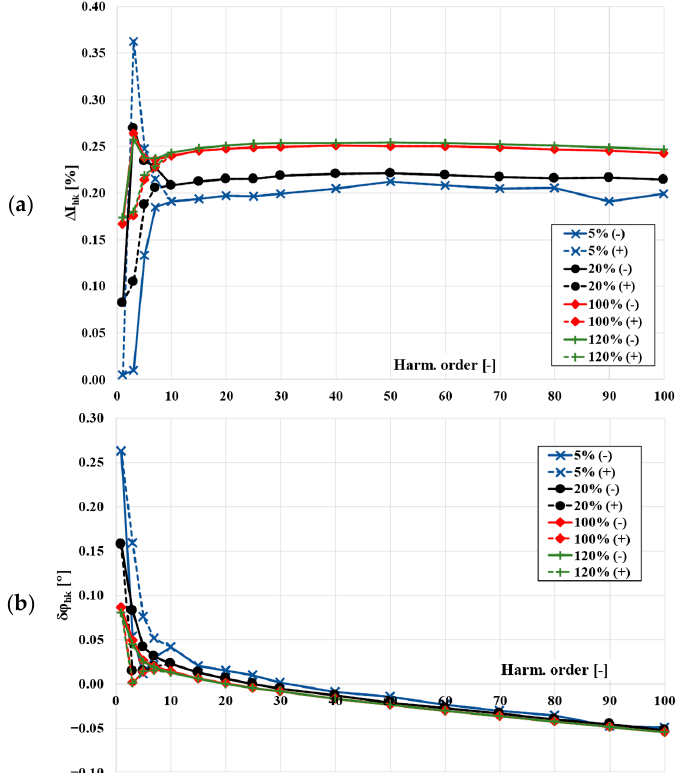
Figure 6. Influence of the 25% of the rated resistive load of the secondary winding of the 100 A/5 A CT on its accuracy: ( a ) current error, ( b ) phase displacement. CT on its accuracy: ( a ) current error, ( b ) phase